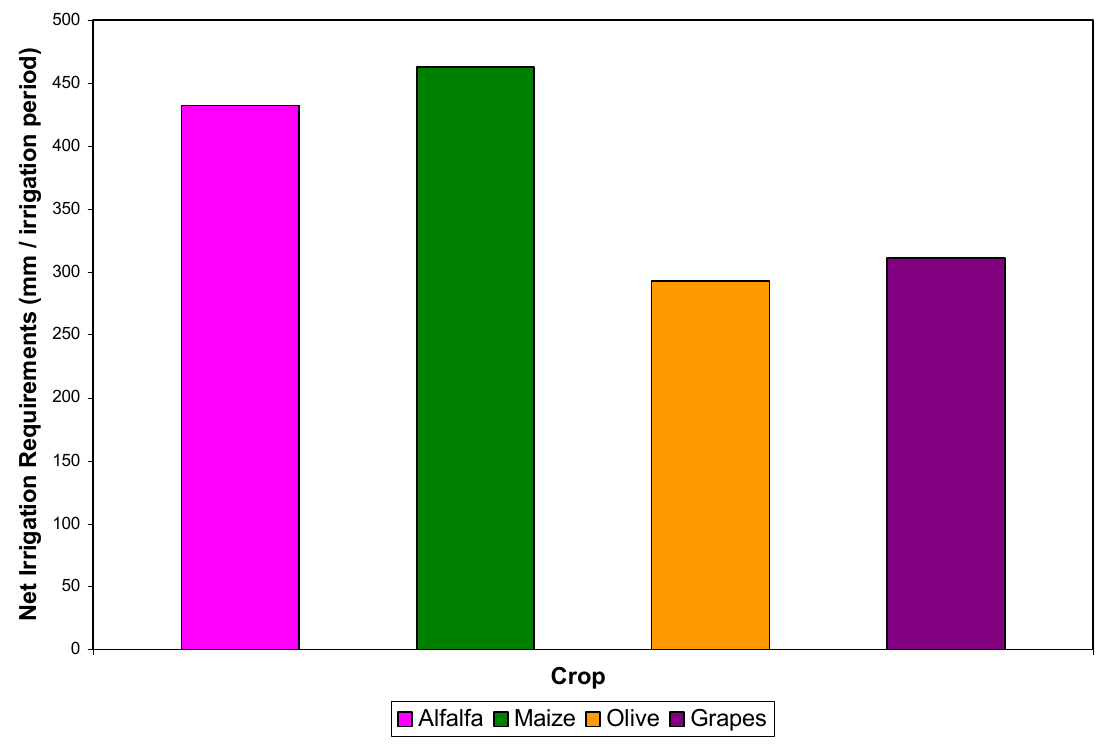
Figure 4. Net Irrigation Requirements for crops in Thermo